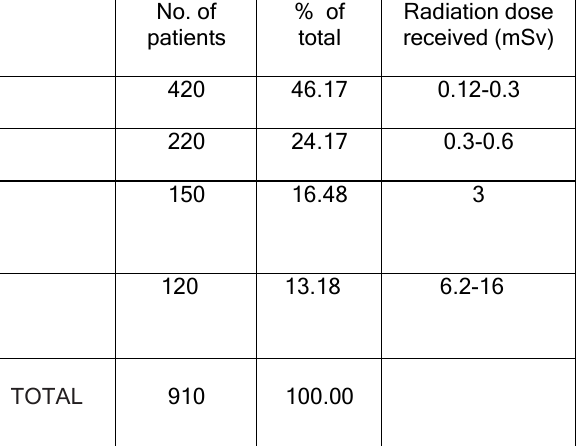
Table-2 summary of patient’s number versus radiation dose.